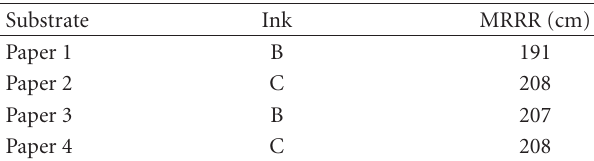
Table 10: The best MRRR values behind five paper reams measured with circularly polarized reader